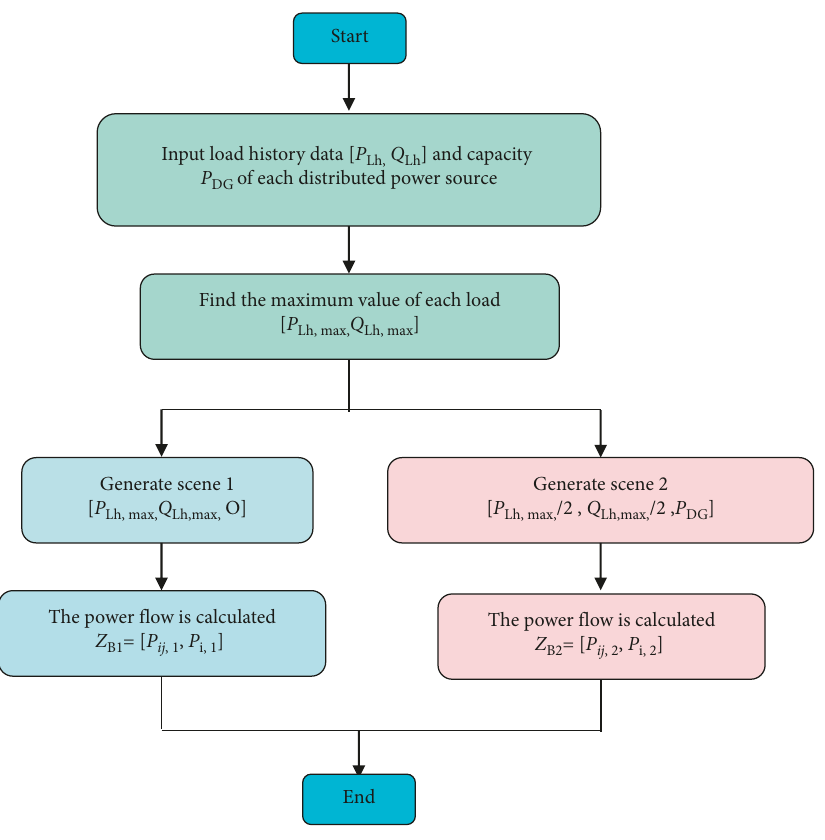
Figure 3: Flow chart of selection of reference